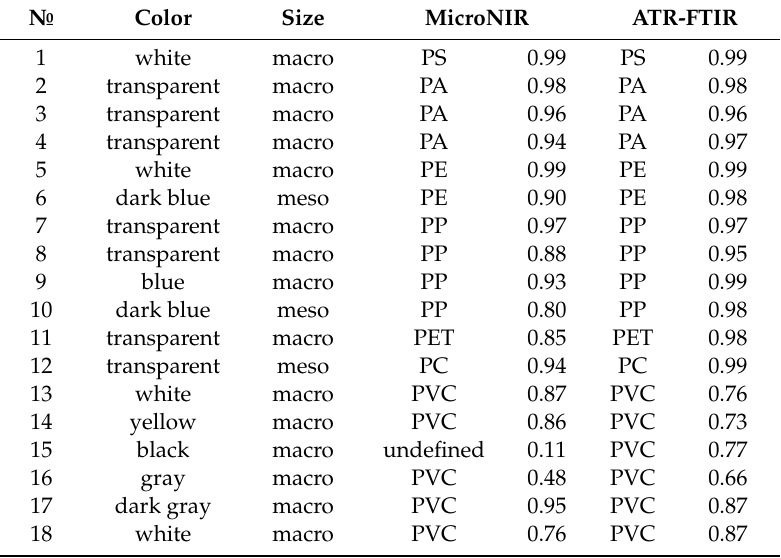
Table 8. Results of microplastic identification found in the surface waters of Eurasian Arctic. Number of Defined Items Polymer MicroNIR on